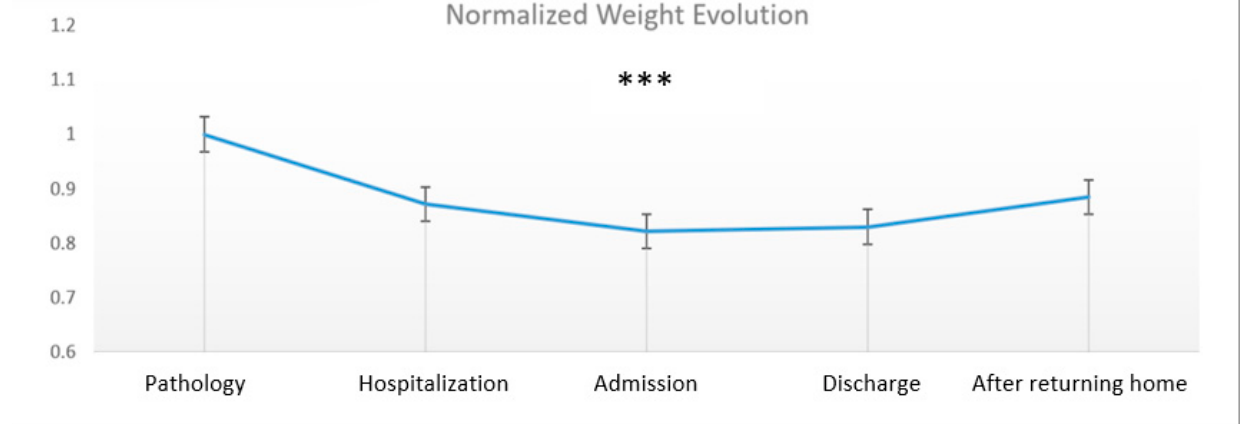
Figure 3. Normalized difference in weight at different temporal phases. *** p < 0.001 as compared to before the pathology.